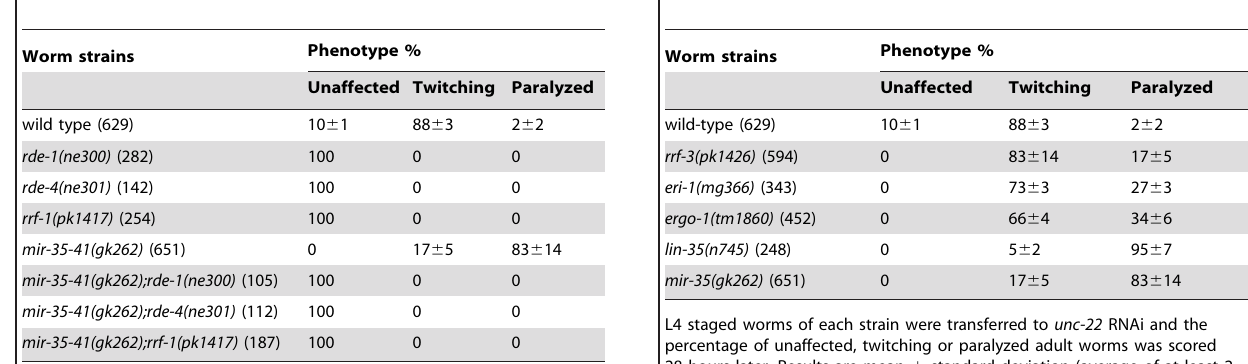
Table 2. The RNAi sensitivity of mir-35-41(gk262) mutant worms is dependent on core RNAi factors.